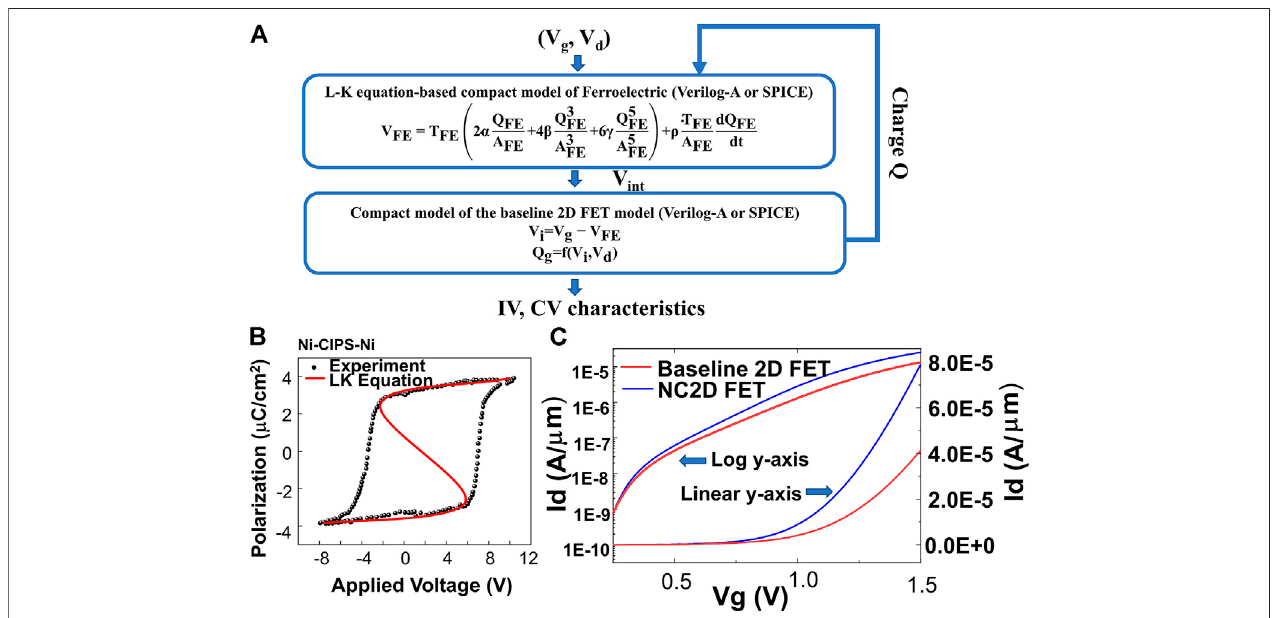
FIGURE2| Devicemodelingmethod oftheNC2DFET. (A) Modeling fl owoftheNC2DFETs. (B) LKcoef fi cientextractionfrom thepreviousEPtest ofthe2DCIPS ferroelectric, α = − 6.59E10 cm/F, β = 6.21E21 cm 2 /F/C 2 , and γ = 1.15E11 cm 9 /F/C 4 . (C) Transfer characteristic comparison between the 2D FETs with/without CIPS incorporation with log y -axis in the left and linear y -axis in the right.